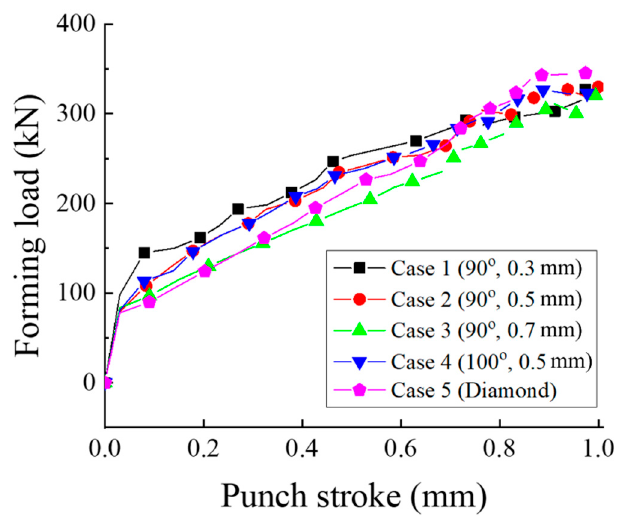
Figure 10. Forming load with punch stroke (FE analysis).